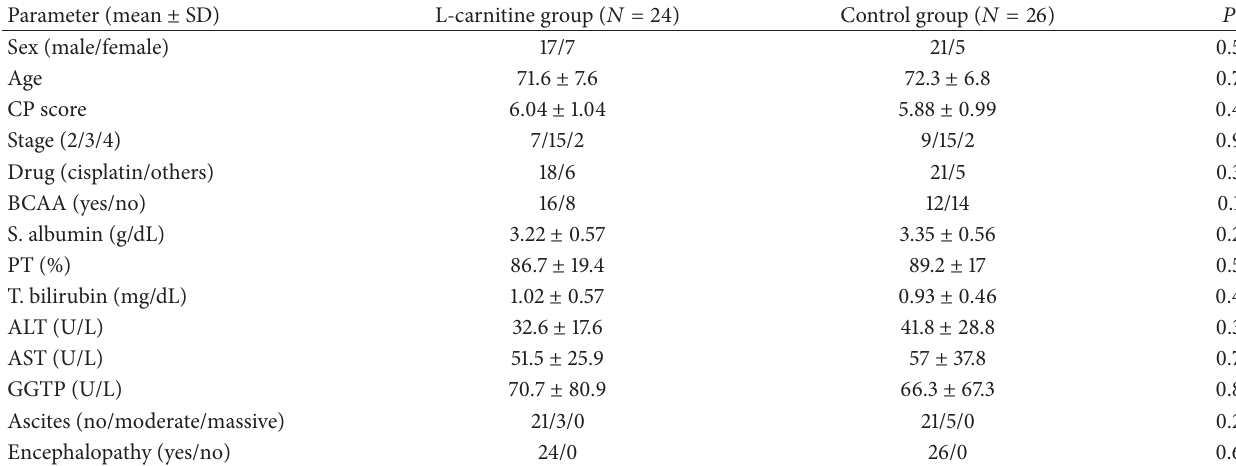
Table 1: Baseline clinical and laboratory